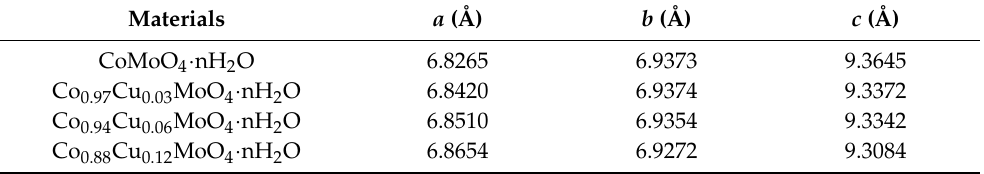
Table 1. Lattice constants a , b and c obtained from the Rietveld refinement for all materials.